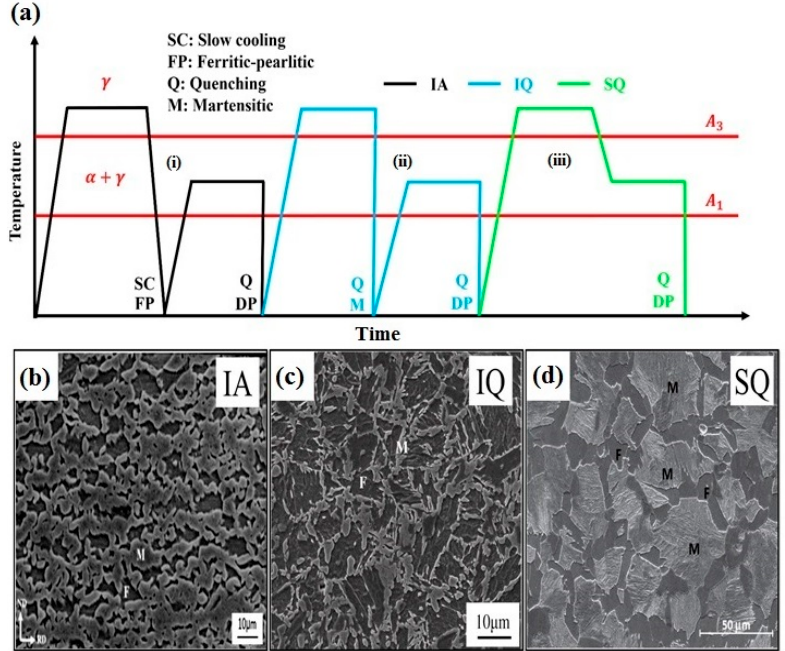
Figure 7. ( a ) Various heat treatment regimes for generation of different MMs in DP steels: (i) IA, (ii) IQ, and (iii) SQ. Various MMs in DP steels: ( b ) globular [38], ( c ) fibrous [66], and ( d )